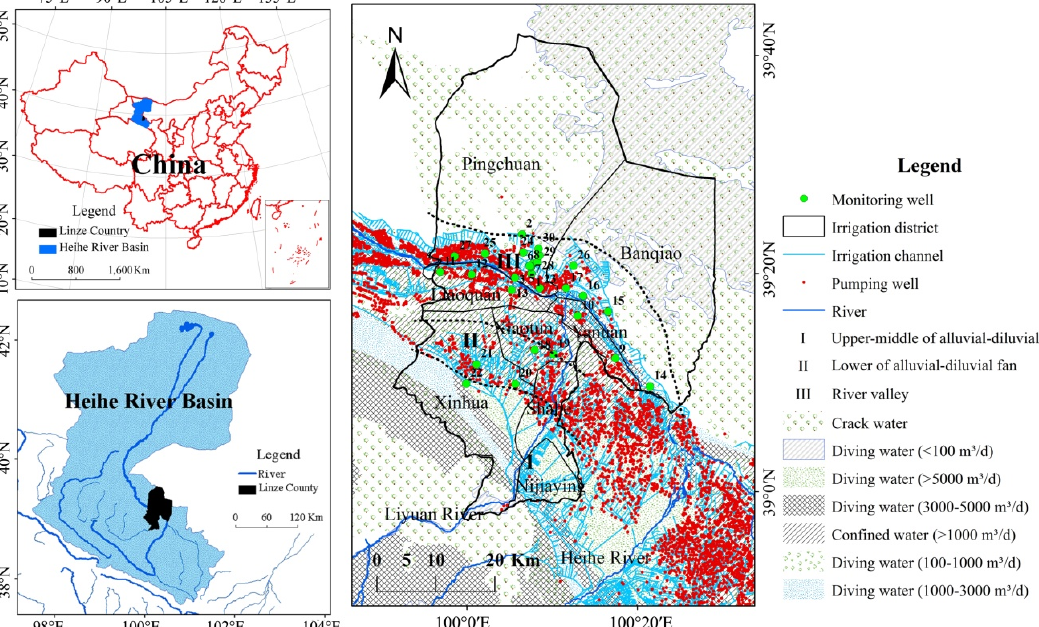
Figure 1. The study area and the distribution of observation wells in Linze County in the Heihe River basin, China.